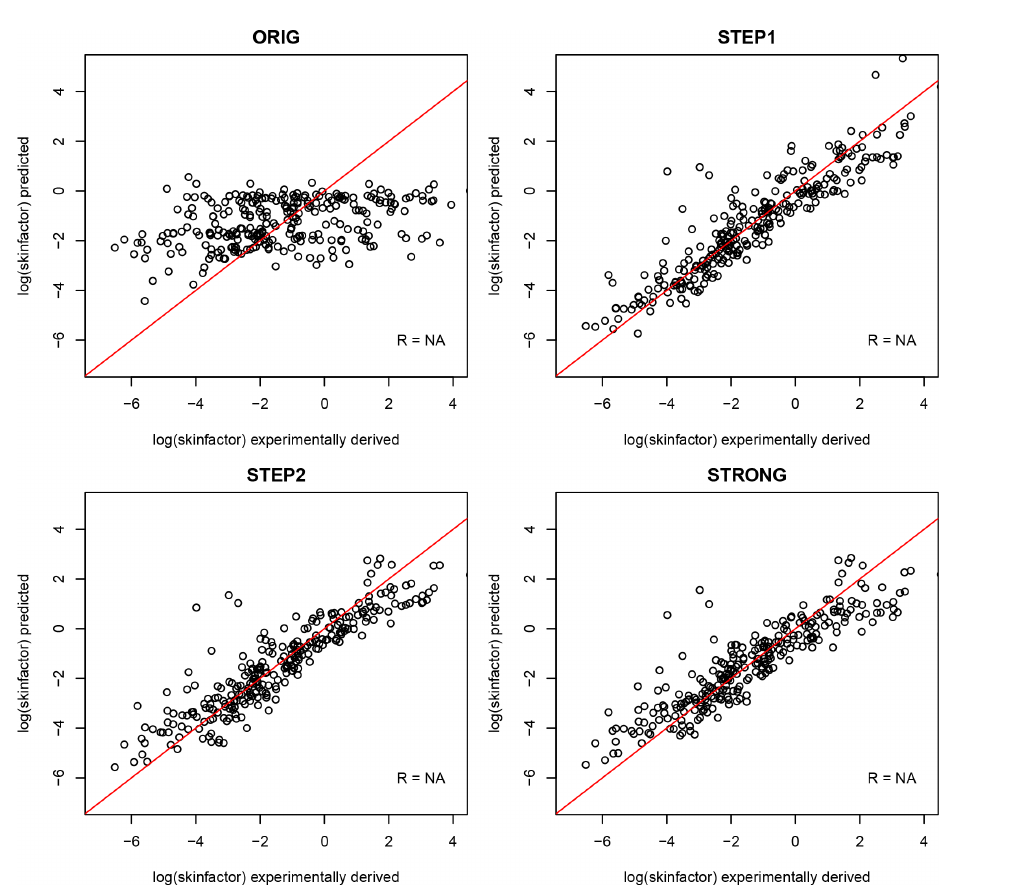
Figure 2. Experimentally derived versus predicted skinfactors (log values) for the selected validation dataset.